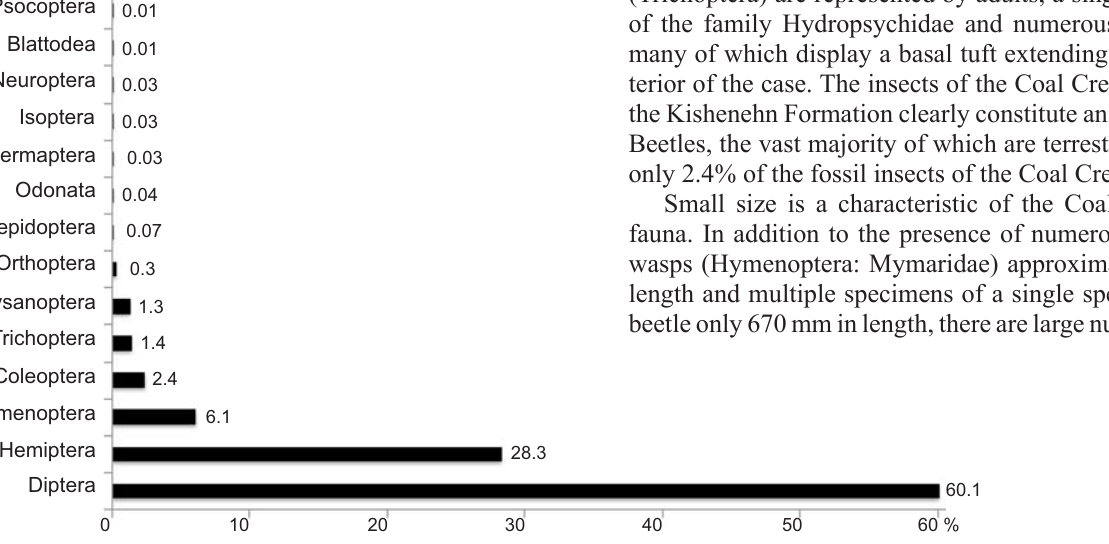
Fig. 3. Distribution of fossil insect orders from the Coal Creek member of the Kishenehn Formation. Percentages of the total insect fossils for each order are given to the right of each horizontal bar. Insects not identifiable to order (8.38% of the total) are not included in the graph. Within Diptera and Hemip- tera, the families Chironomidae (nonbiting midges) and Corixidae (water boatmen) respectively, make up the majority of the